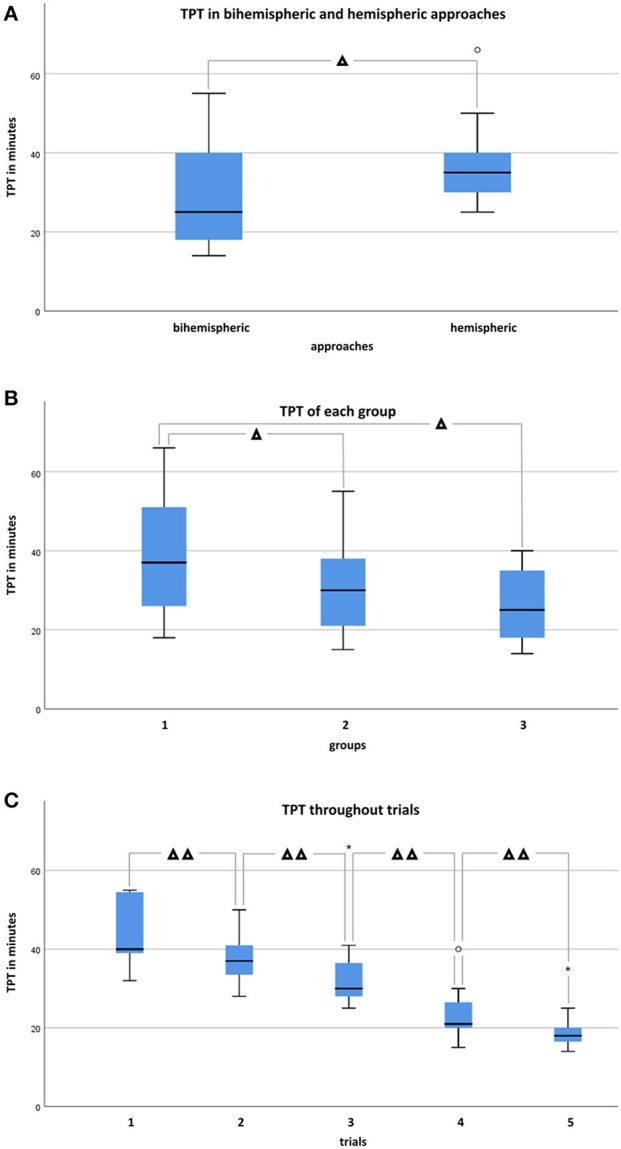
Demonstrates confrontation of total procedure times (TPT) in minutes in box and whisker plots between bihemispheric and hemispheric approaches, levels, and trials. (A) TPT in bihemispheric (n = 33) and hemispheric (n = 22) tailored brains throughout groups. Mann-Whitney-U-test identified a statistically significant difference between bihemispheric and hemispheric approaches if considered for all groups (p < 0.05), but significance was not achieved if groups were considered individually (group I, n = 20, p = 0.296; group II, n = 25, p = 0.060; group III, n = 10, p = 0.386). (B) TPT throughout approaches and trials of each group. Experienced raters performed faster than the less experienced group (One-way ANOVA, post-hoc Dunnett-T) if group III (n = 10) and I (n = 20), as well as group II (n = 25) and I (n = 20) were compared to each other (p < 0.05), but not (p = 0.999) if comparison was performed between group III (n = 10) and II (n= 25). (C) TPT throughout groups significantly decreased (Kendall-Tau-b = −0.663, p < 0.001) from trials 1 (n =11) to 5 (n = 11). °Indicates individual Outliers and *Extremes. Significant differences are indicated with Δ for p < 0.05 and with ΔΔ for p < 0.001.